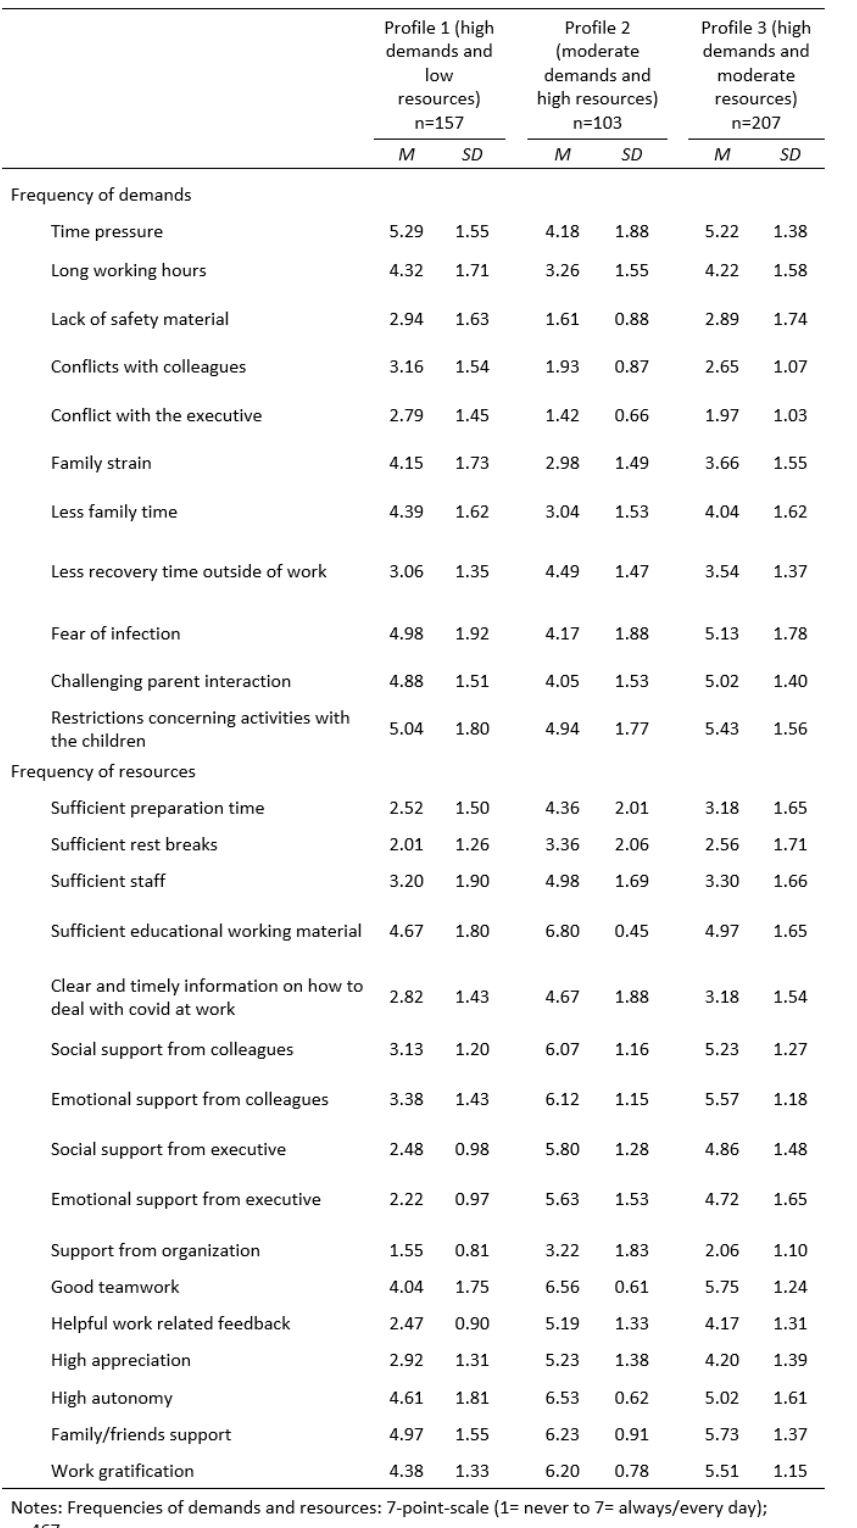
Table 2. Frequencies of demands and resources of the latent profiles; means, and standard